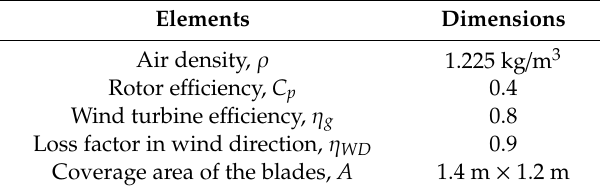
Table 5. Parameters for calculating the electricity generation of the wind turbine [58].